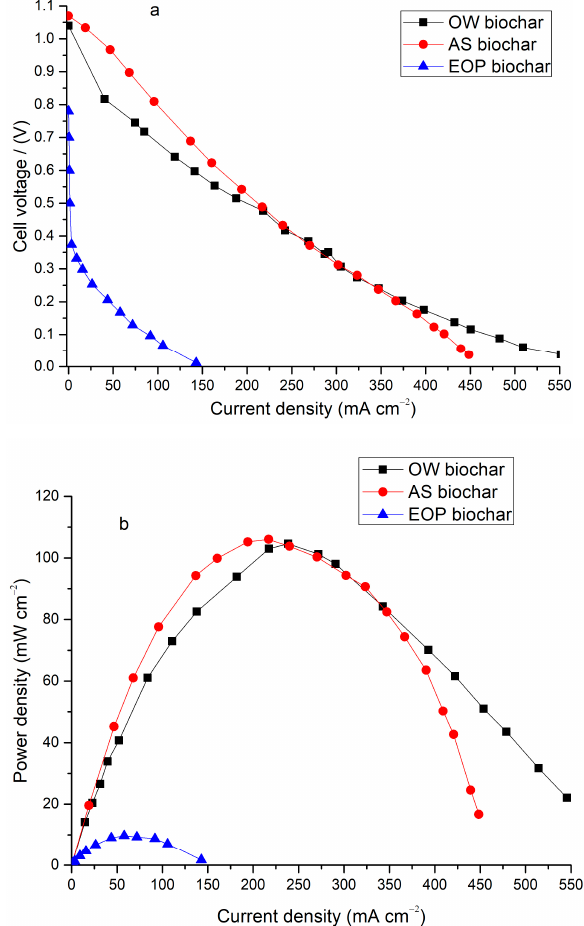
Figure 9. ( a ) I–V and ( b ) I–P curves of the DCFC powered by the EOP biochar at 700 °C,